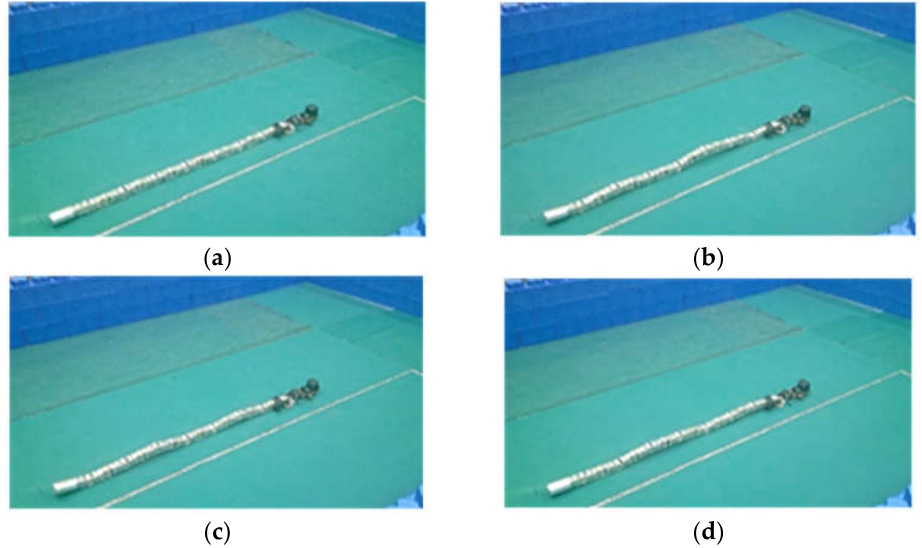
Figure 15. Head stabilization experiment with stabilization algorithm. ( a ) Phase is 0; ( b ) phase is π/2; ( c ) phase is π; ( d ) phase is 3 π/2.